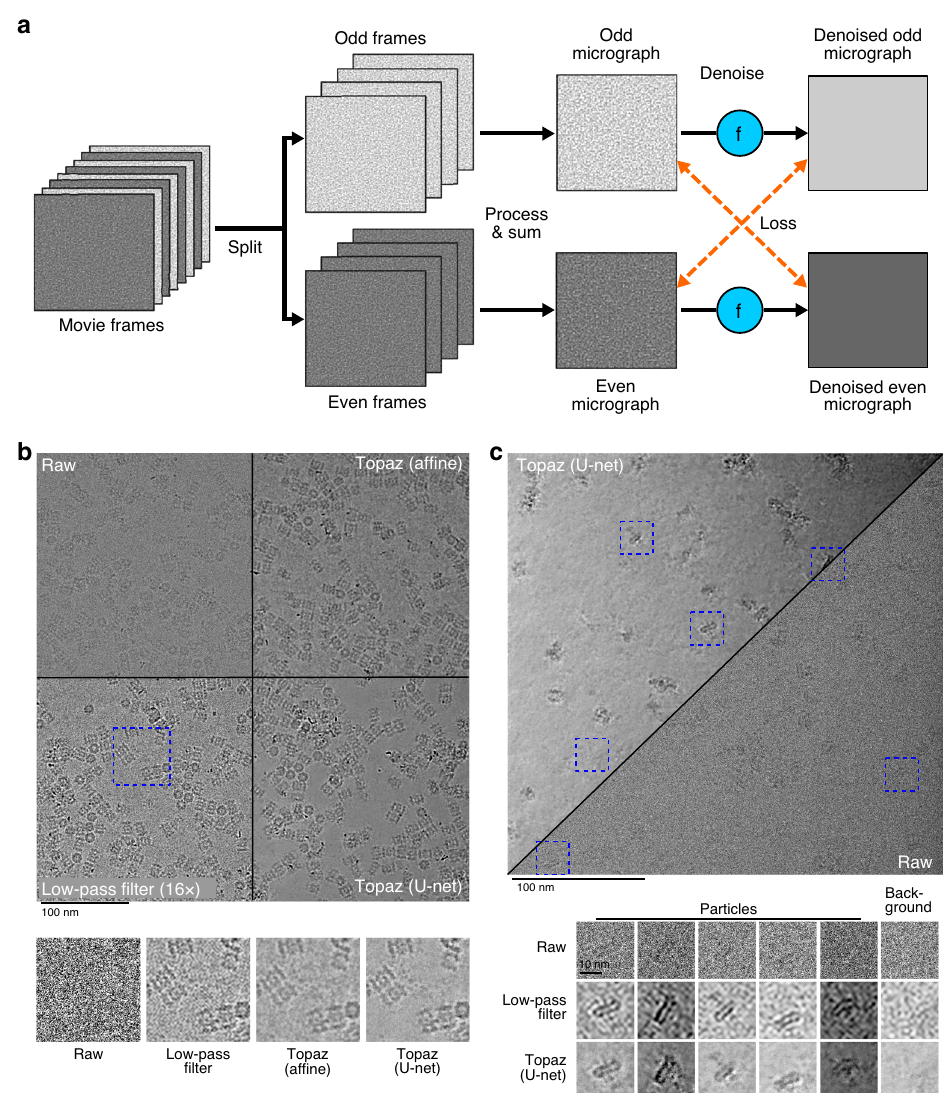
Fig. 1 Illustration of the training framework and comparison of denoising methods on two example micrographs. a The Noise2Noise method requires paired noisy observations of the same underlying signal. We generate these pairs from movie frames collected in the normal cryoEM process, because each movie frame is an independent sample of the same signal. These are fi rst split into even/odd movie frames. Then, each is processed and summed independently following standard micrograph processing protocols. The resulting even and odd micrographs are denoised with the denoising model (denoted here as f ). Finally, to calculate the loss, the odd denoised micrograph is compared with the raw even micrograph and vice versa. b Micrograph from EMPIAR-10025 split into four quadrants showing the raw micrographs, low-pass fi ltered micrograph by a binning factor of 16, and results of denoising with our af fi ne and U-net models. Particles become clearly visible in the low-pass fi ltered and denoised micrographs, but the U-net denoising shows strong additional smoothing of background noise. A detail view of the micrograph is highlighted in blue and helps to illustrate the improved background smoothing provided by our U-net denoising model. c Micrograph from EMPIAR-10261 split into the U-net denoised and raw micrographs along the diagonal. Detailed views of fi ve particles and one background patch are boxed in blue. The Topaz U-net reveals particles and reduces background (Supplementary Table 1). Note that the L2 af fi ne fi lter is also the model, and micrographs denoised with conventional methods. We chose to measure SNR using real cryoEM micrographs because the denoising models were trained on real micrographs generated under real-world conditions that no software accurately simulates. Due to the lack of ground truth in cryoEM, SNR calculations are estimates (Methods). We manually annotated paired signal and background regions on micrographs from 10 different datasets (Supplementary Fig. 8). We then calculated the average SNR (in dB) for each method using these regions 23 . We present a comparison of four different denoising model architectures (af fi ne, FCNN, U-net (small), and U-net) trained with L1 and L2 losses on either the small or large datasets